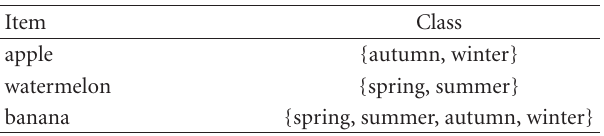
Table 1: Item class.